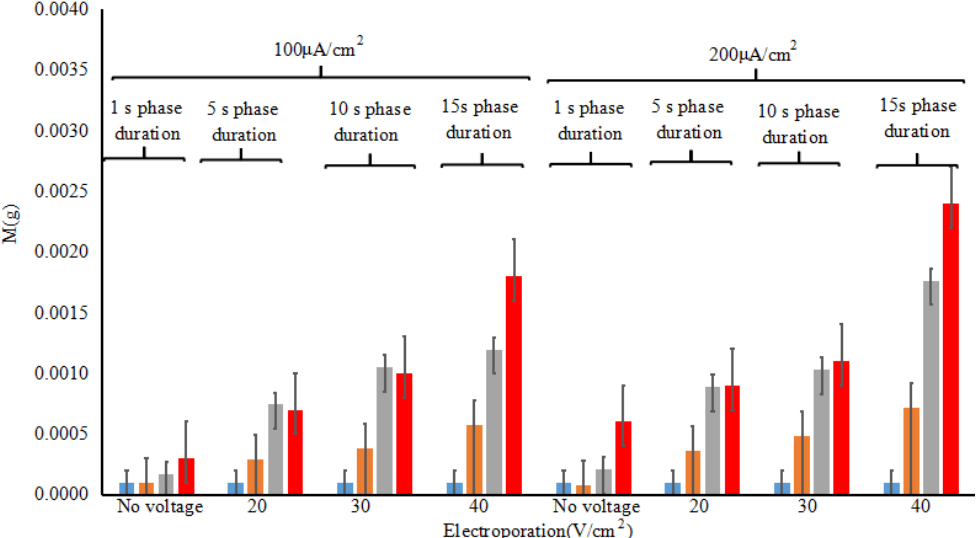
Figure 12 . Effect of electroporation (electric field strength = 0~40 V/cm 2 , pulse width = 10 ms, number of pulses per second = 10, duration 5 min) and reverse iontophoresis (symmetrical biphasic dc; current density = 0.1~0.2 mA/cm 2 ; reversed every 3 min during the 12 min) on the difference of ISF extraction pre-experimental to post-experimental by measuring weight under different conditions.